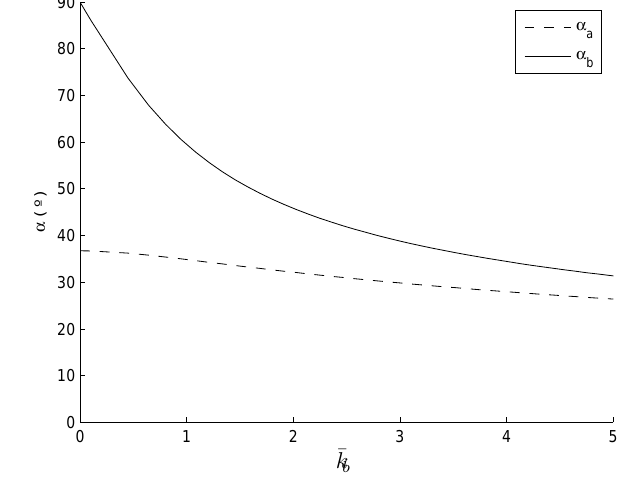
Fig. 3. Angles α a and α b versus normalized wave-vector k b